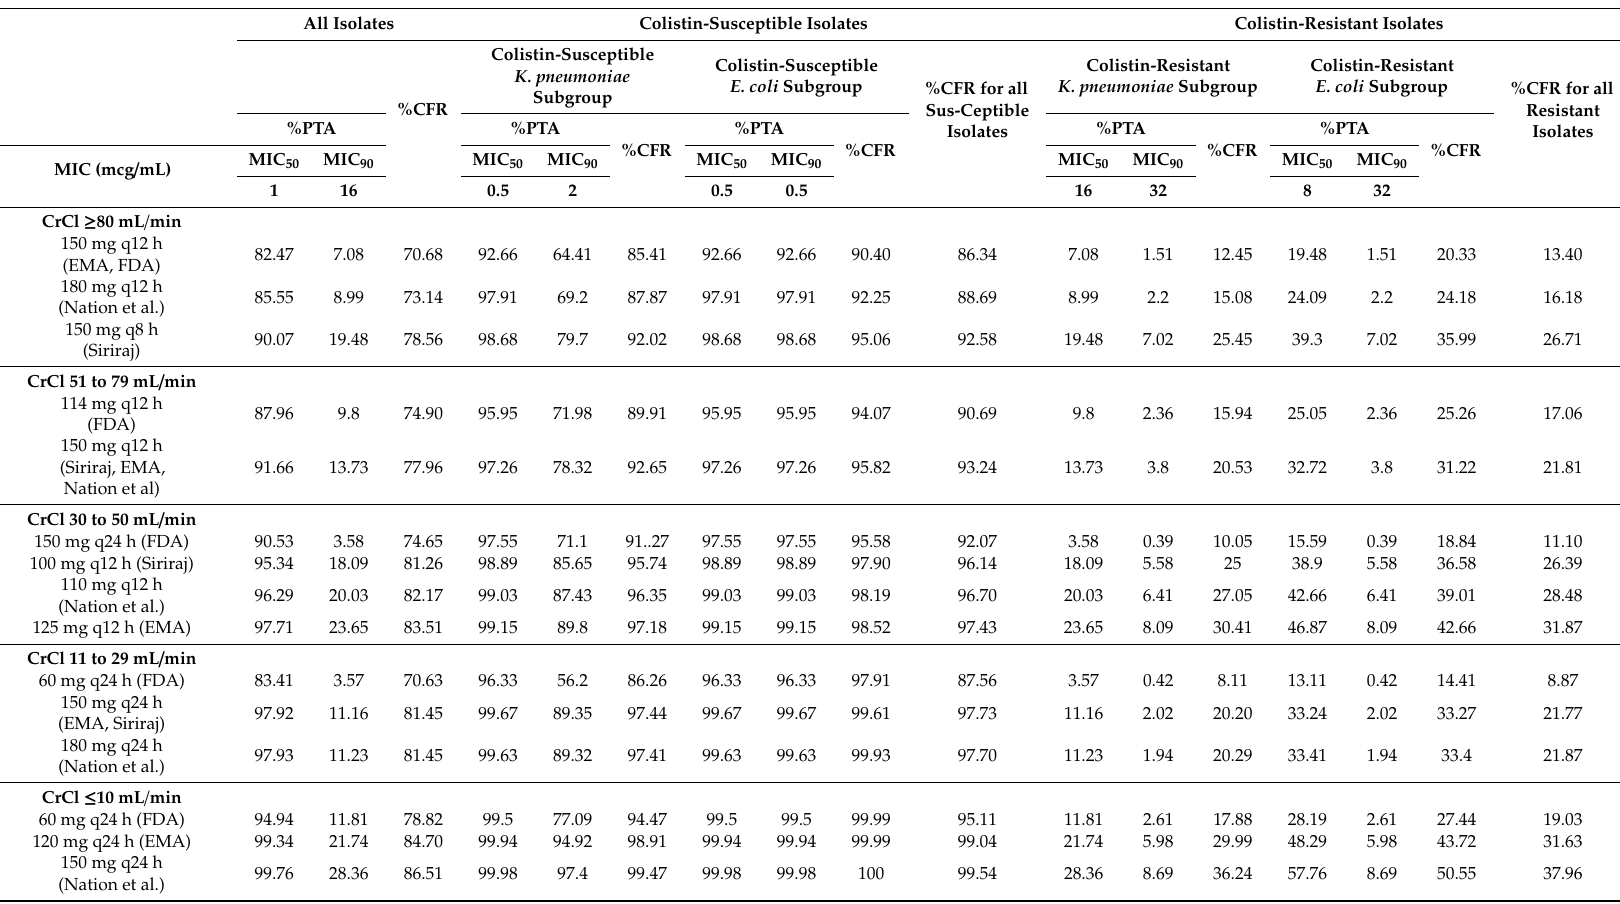
Table 7. %PTA and %CFR for All isolates, Colistin-susceptible isolates subgroup and Colistin-resistant isolates subgroup. All